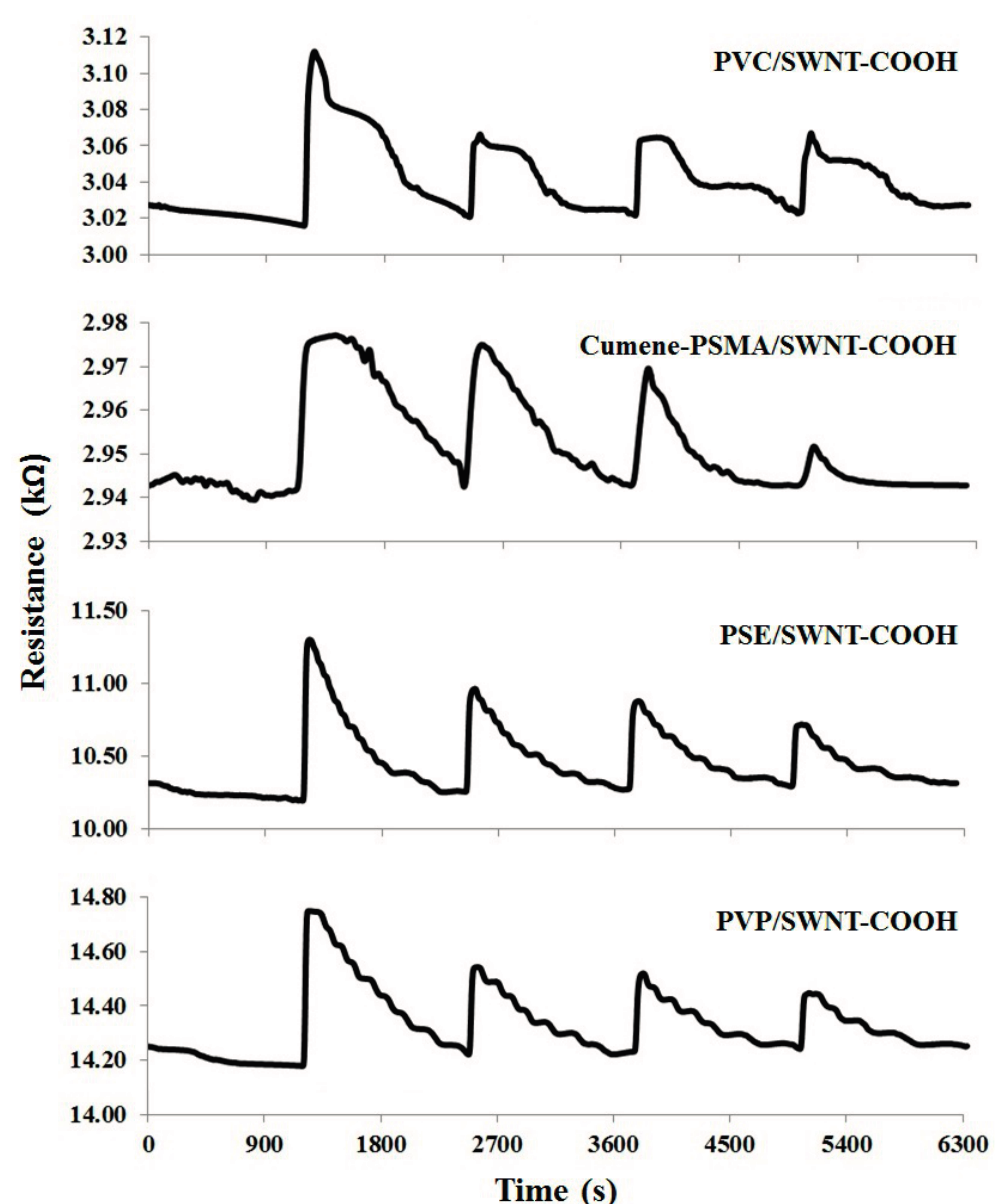
Figure 9. The dynamic response to urine odor by four fabric-based chemical gas